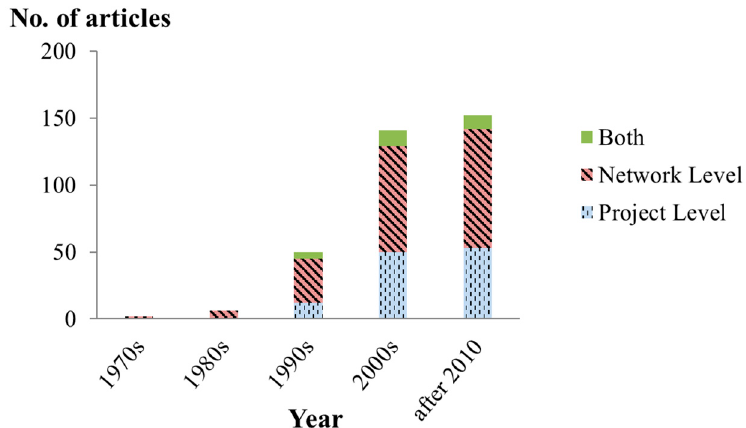
Figure 2. Levels of decision making.